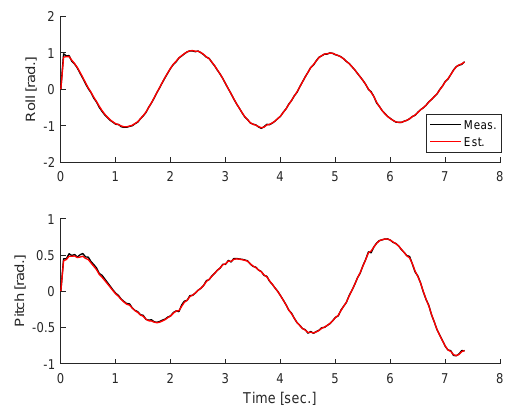
Figure 5: The system was simulated where the covariance describing the uncertainties in the measurements was 10 times larger than the covariance describing the uncertainties in the system